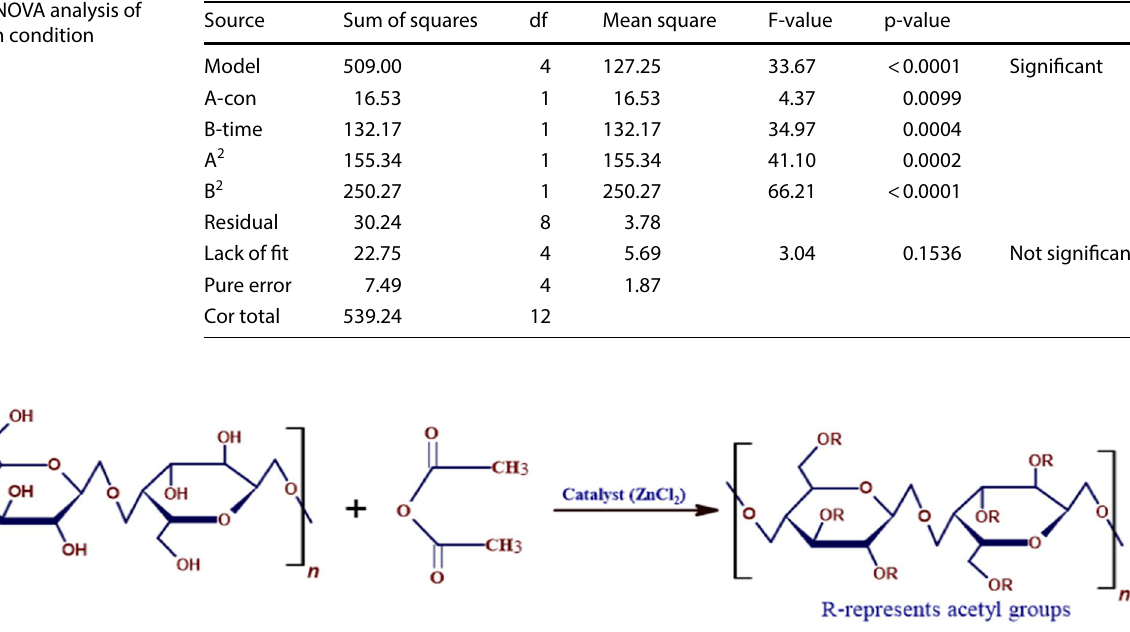
Fig. 3 Acetylation reaction mechanism of